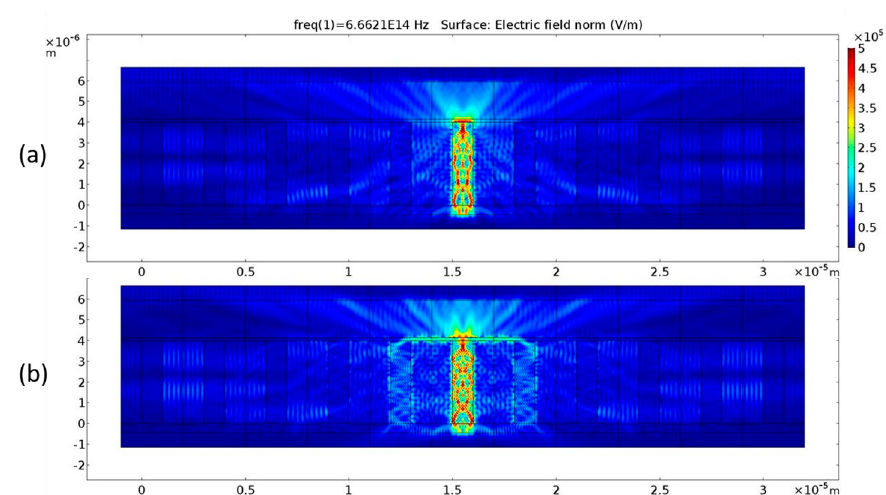
Figure 2. Simulation results of LED array comprising 11 fins with a width of 1 µm and a dipole emission at 450 nm from the middle fin. Localized top emission can be obtained from the LED fin ( a ) without top contact. LED fin with connecting ITO p -contact line showing optical crosstalk and widened side lobes ( b ).